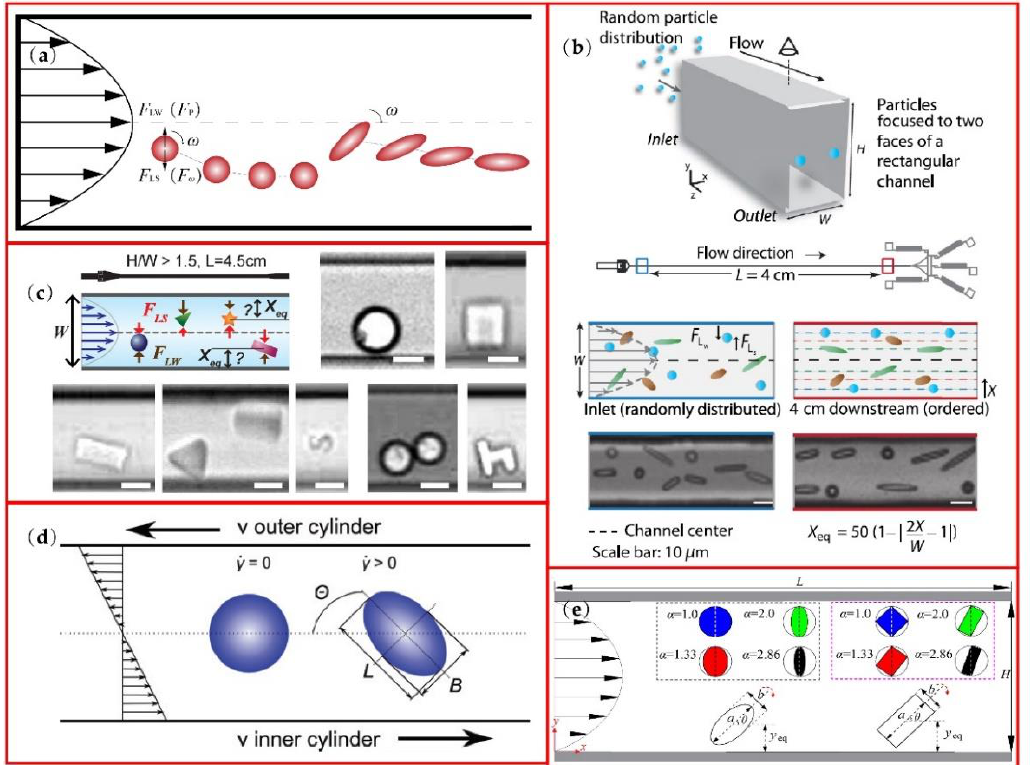
Figure 4. Non-spherical particle manipulation in straight microchannels: ( a ) sketch of particle focusing in a Poiseuille flow; ( b ) ellipsoids with different aspect ratios focusing, reprinted from [36]; ( c ) microparticles with various shapes in a straight microchannel; ( d ) non-spherical capsule rotation in a shear flow; ( e ) elliptical particle and rectangular particle migrating in a channel flow. Figure ( c ) is reprinted with permission from [29], Copyright 2011 AIP publishing. Figure ( d ) is reprinted with permission from [75], Copyright 2015 Elsevier. Figure ( e ) is reprinted with permission from [84], Copyright 2021 Elsevier.